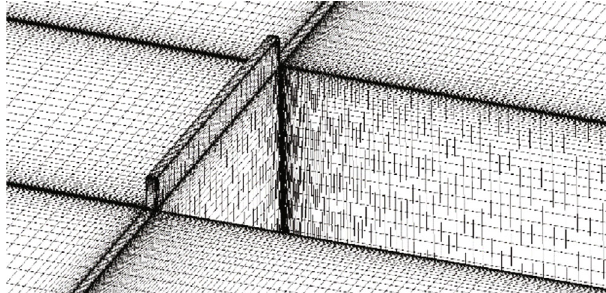
Figure 10: Cavity with rectangular fence.